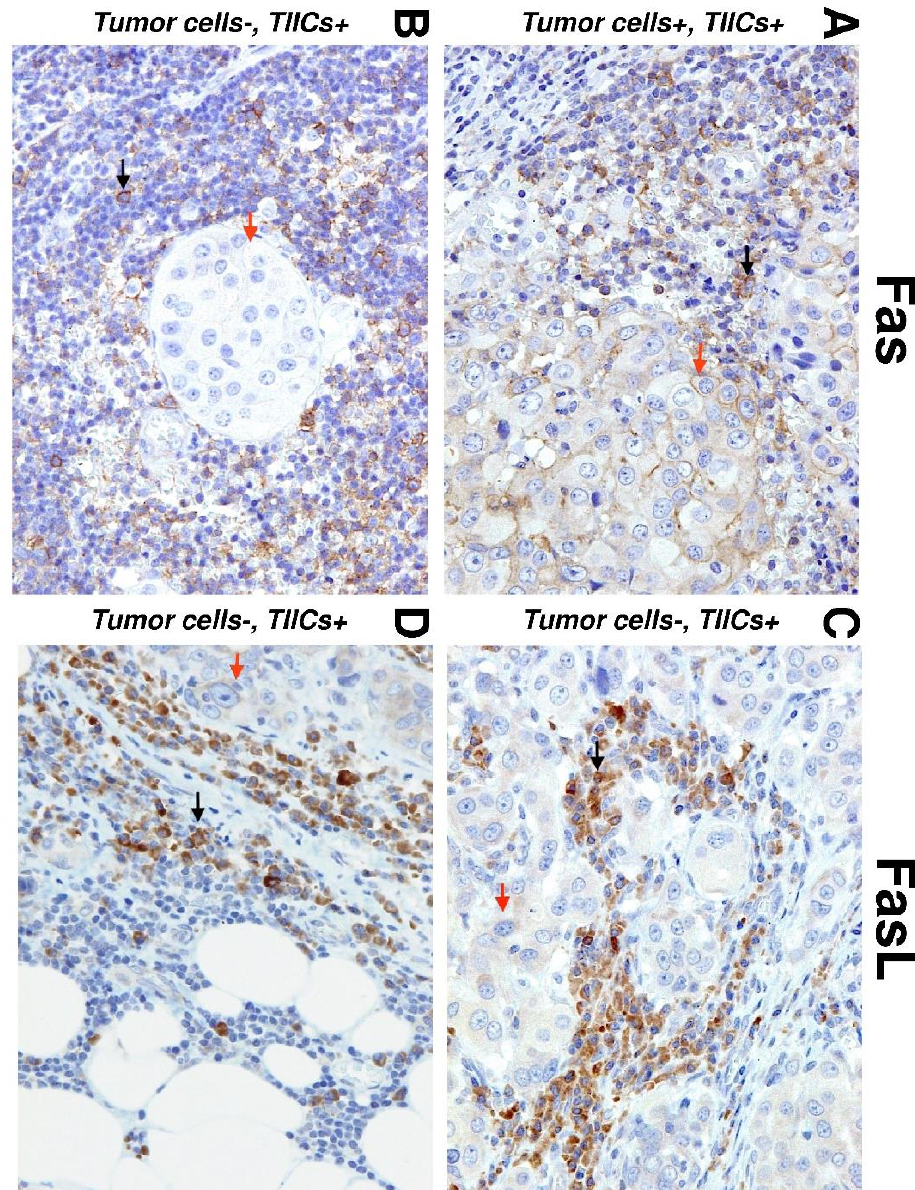
Figure 1. Immunohistochemistry (IHC) of Fas and Fas ligand (FasL) expression in salivary gland carcinoma (SGC) tissues. Representative images show Fas (left) and FasL (right) staining in tumor cells (red arrows) and tumor-infiltrating immune cells (TIICs) (black arrows) in the tumor periphery. ( A ) IHC shows positive Fas staining in TIICs and tumor cells (20×). ( B ) IHC shows negative Fas staining in tumor cells and positive Fas staining in TIICs (20×). ( C ) IHC shows positive FasL staining in tumor cells and TIICs (20×). ( D ) IHC shows negative FasL staining in tumor cells and positive FasL staining in TIICs (20×).